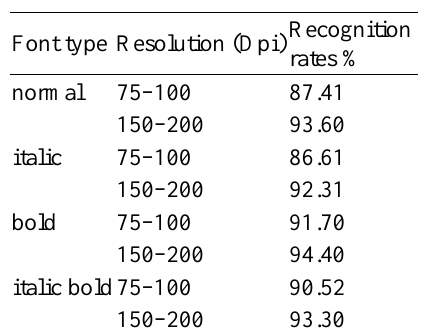
Table 5. Recognition rates of printed characters in different font types and